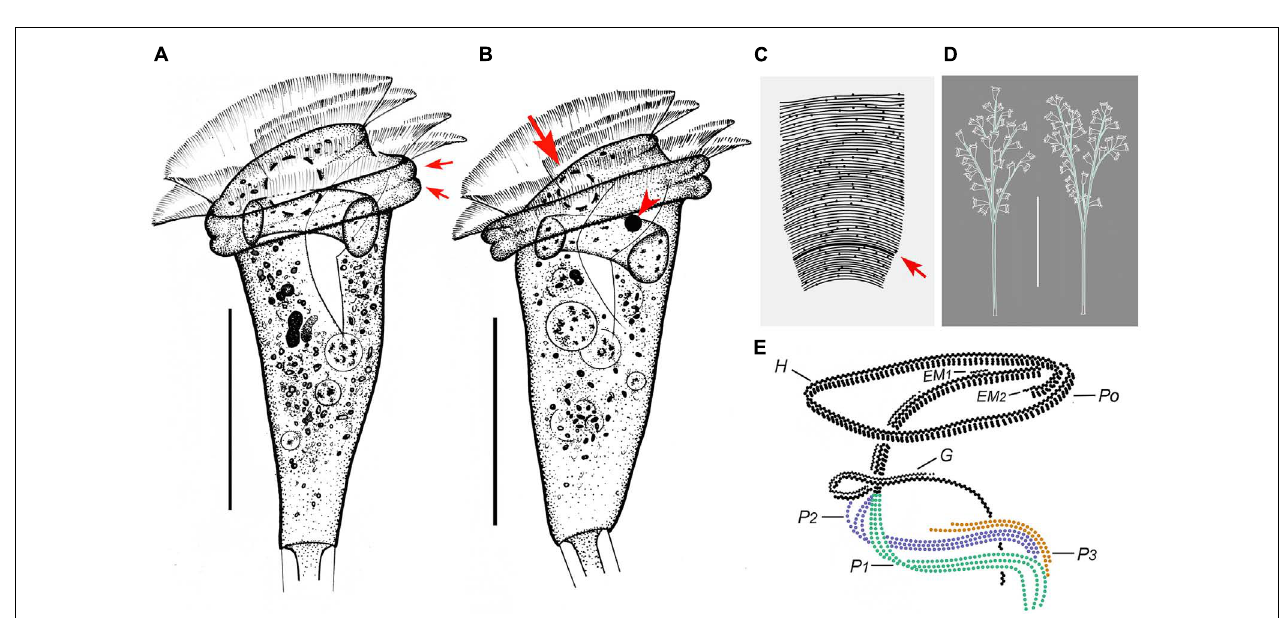
FIGURE 6 | Zoothamnium weishanicum n. sp. in vivo (A,B,D) , after “dry” silver nitrate staining (C) , and after protargol staining (E) . (A,B) Different zooids showing the shape variation; arrows in panel (A) mark the double-layered peristomial lip, arrow in panel (B) marks the contractile vacuole, and arrowhead in panel (B) marks the micronucleus. (C) Silverline system; arrow marks the trochal band. (D) Two mature colonies. (E) Oral ciliature. EM1, 2, epistomial membrane 1, 2; G, germinal kinety; H, haplokinety; Po, polykinety; P1–3, infundibular polykineties 1–3. Bars: 40 µ m in panels (A,B) and 500 µ m in panel (D)